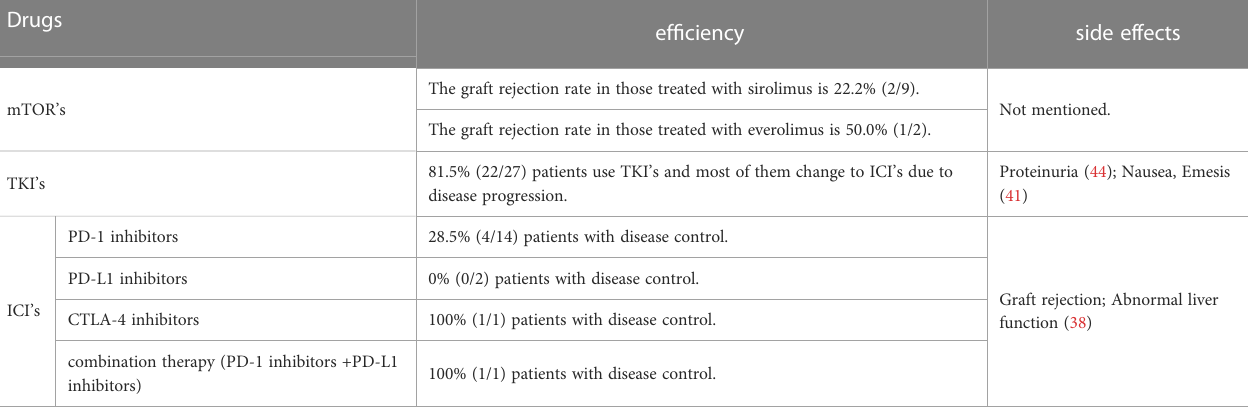
TABLE 3 The ef fi ciency and side effects of each drug based on the existing data. Drugs